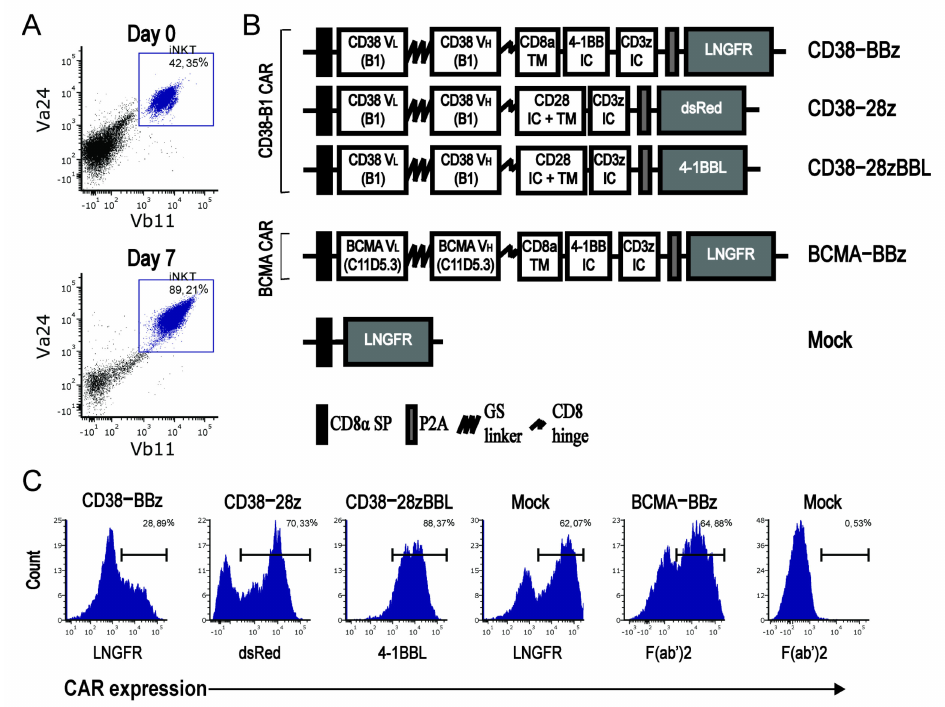
Figure 1. Invariant natural killer T (iNKT) cell isolation and CAR expression. ( A ) Representative dot plots depicting the gating strategy of iNKT cells by flow cytometry after purification with beads at Day 0 and at time of transduction on Day 7. ( B ) Schematic overview of different CD38- and BCMA-CAR (B cell maturation antigen-chimeric antigen receptor) constructs used; CAR expression is determined by expression of surrogate markers low-affinity nerve growth factor (LNGFR), dsRed, or 4-1BBL. ( C ) Flow cytometry histograms illustrating the surrogate marker expression of LNGFR and 4-1BBL as detected by APC-conjugated antibodies or by constitutive dsRed expression on the iNKT cells. The BCMA-CAR expression was determined by goat anti-mouse IgG polyclonal antibody targeting the murine sequence of the heavy and light chains of the CAR. Data are representative of independent transductions in iNKT cells of 3 donors for CD38-CARs and 6 donors for